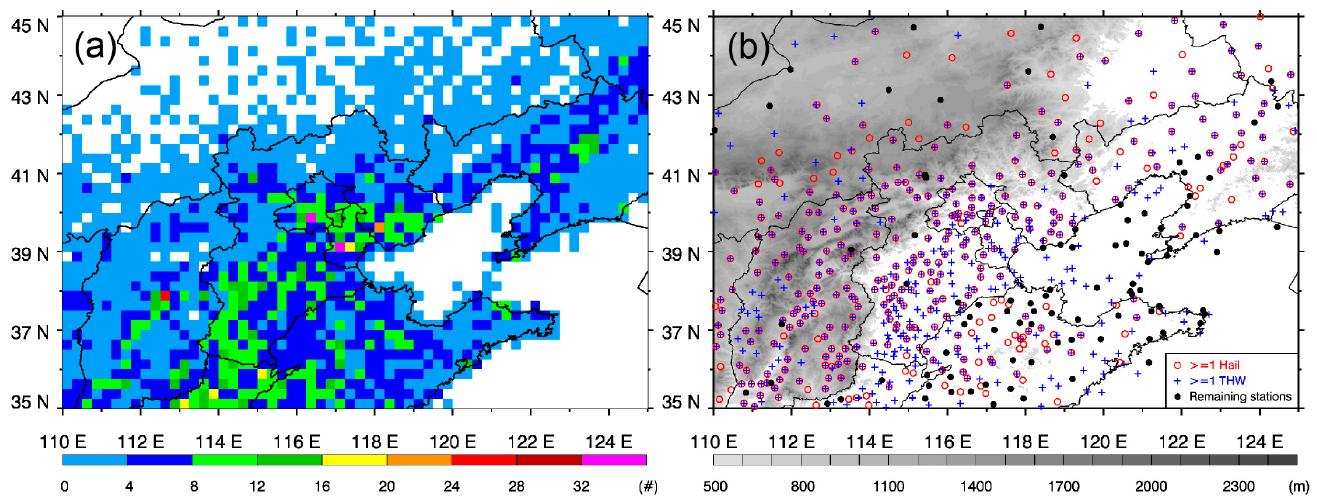
Figure 2. Spatial distribution of the ( a ) precipitation stations in 2011 over North China in 0.25° × 0.25° grid boxes. ( b ) stations in the SWRs dataset during the warm seasons of 2011–2018 over North China. In panel ( b ), red circles (plus signs) indicate stations that have at least one occurrence of hail (THWs) during the study period, and the remaining stations are marked in black dots. Gray shadings represent topography.